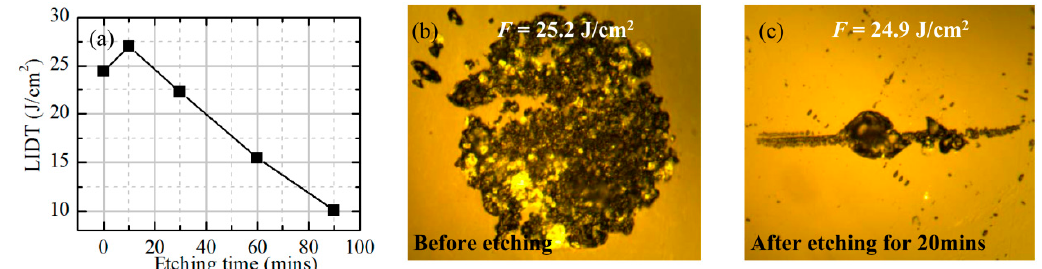
Figure 14. Comparison of the laser damage performance for fused silica optics before and after HF etching. ( a ) Variation of laser-induced damage thresholds (LIDTs) of etched silica surface under various etching times. The typical laser damage morphologies on un-etched ( b ) and etched ( c ) silica surfaces. The microscopic images in ( b , c ) are both magnified by 40 times.